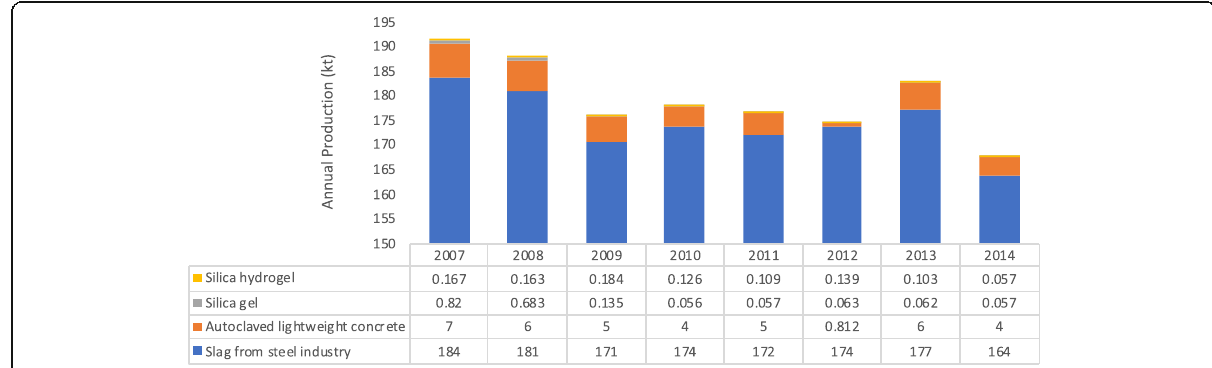
Fig. 1 Annual production of authorized silica